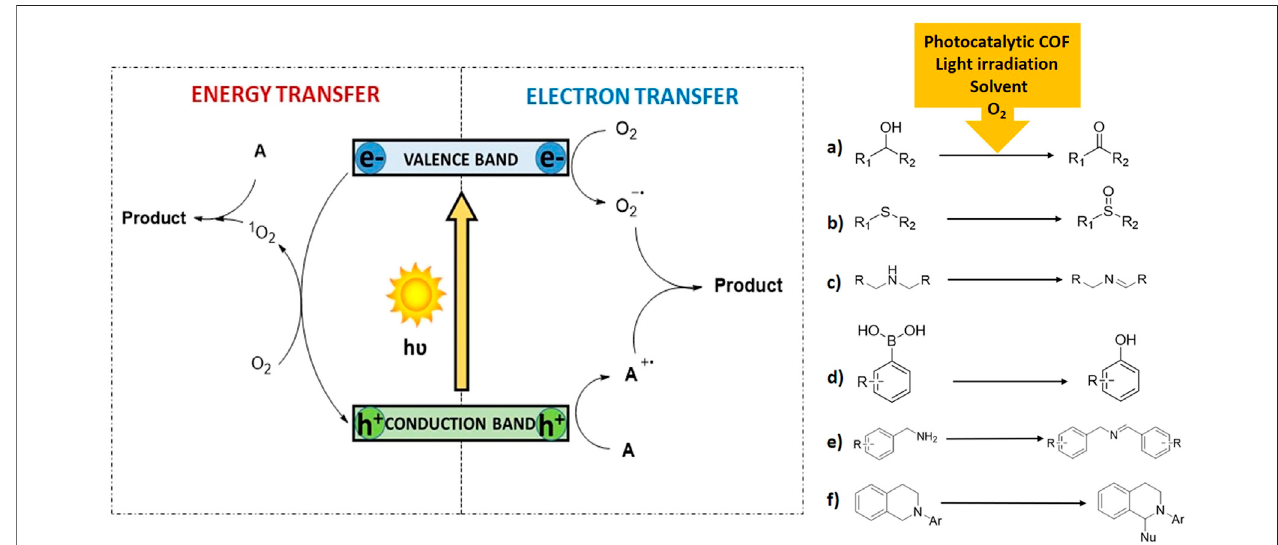
FIGURE 1 | Two different mechanism for oxidation reaction using organic materials (left) and main organic erobic oxidations of organic substrates (right) .